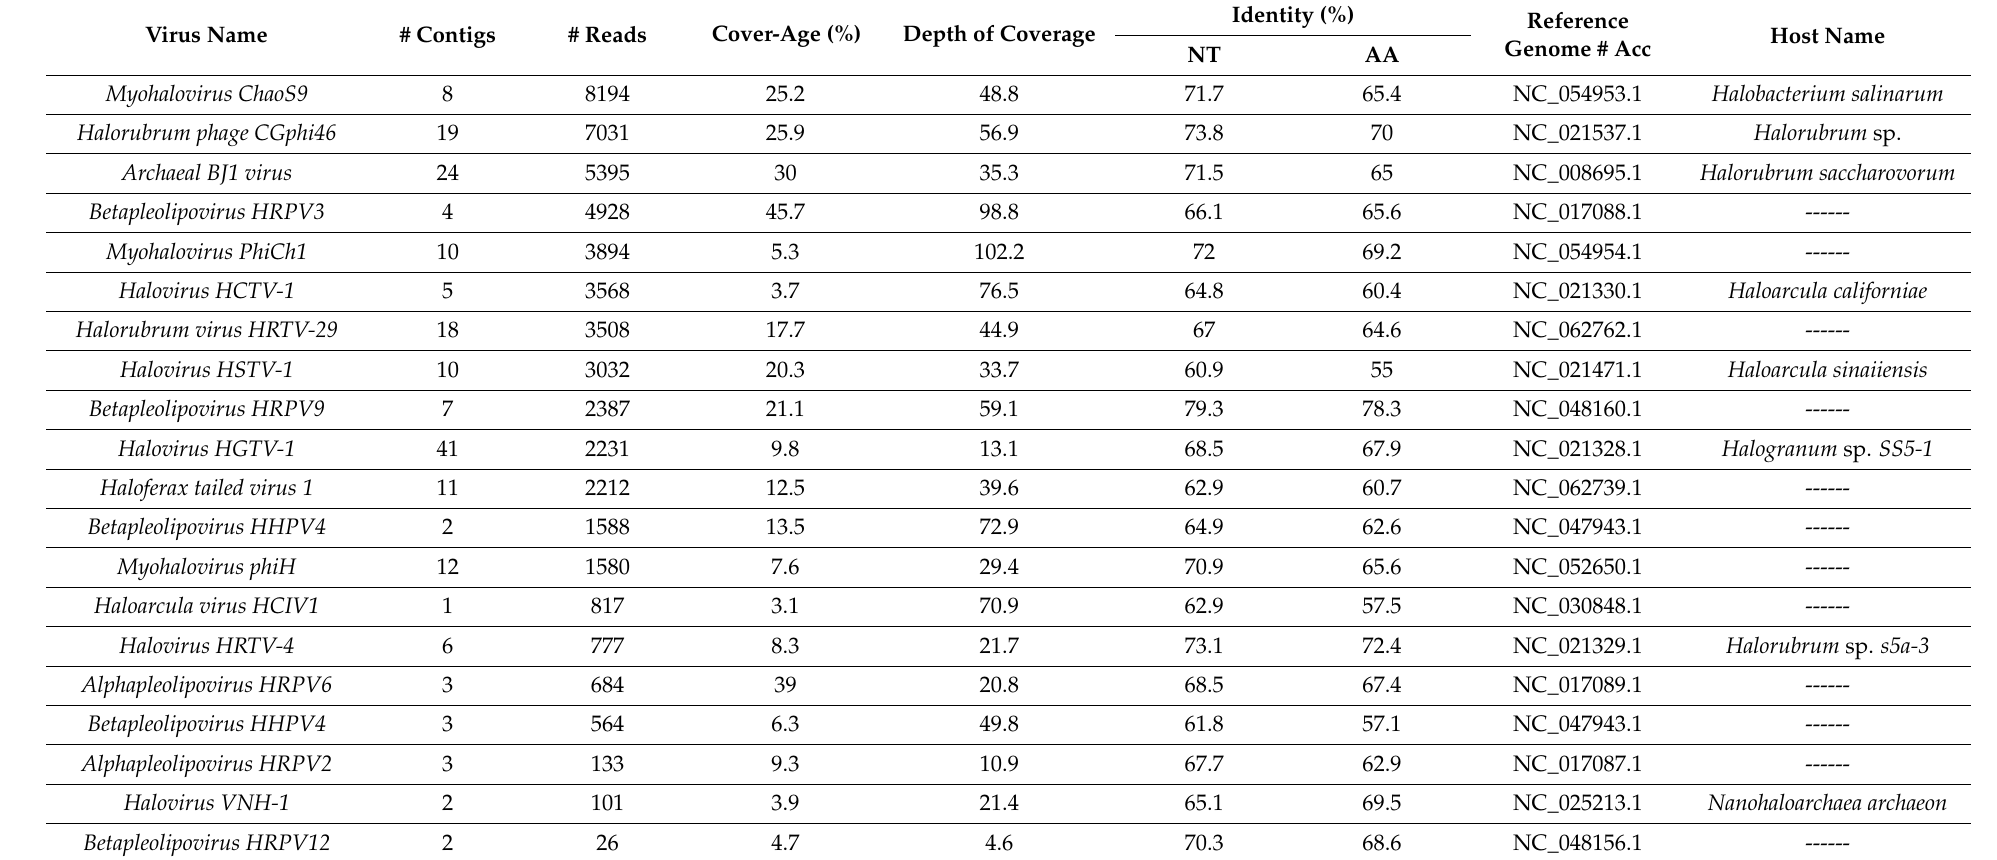
Table 2. Virome species in brine sample detected by Genome Detective online